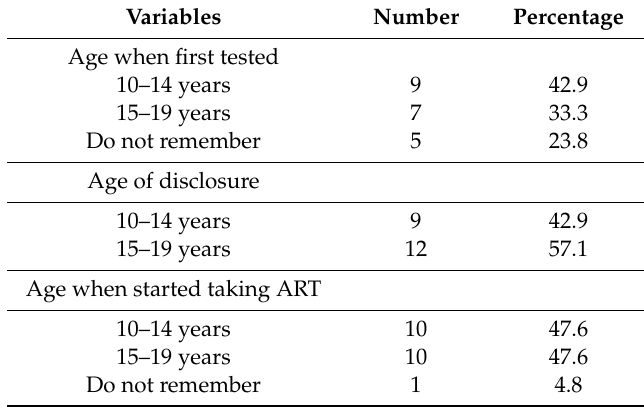
Table 2. Age first tested, age of disclosure, and age when started taking antiretroviral therapies (ARTs).